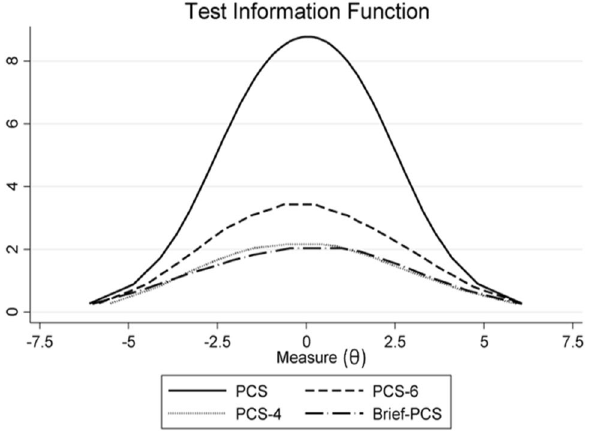
Figure 2. Test information function (TIF, in inverse-square-logits units) related to the four versions of the PCS: 13-item full version (PCS) and short forms (PCS-6, PCS-4, and Brief-PCS). The TIF is a graphical representation of the precision of each scale according to each individual pain catastrophizing level (θ). A TIF of 4 (roughly corresponding to a SE of 0.5) has been defined as the threshold for acceptable precision.